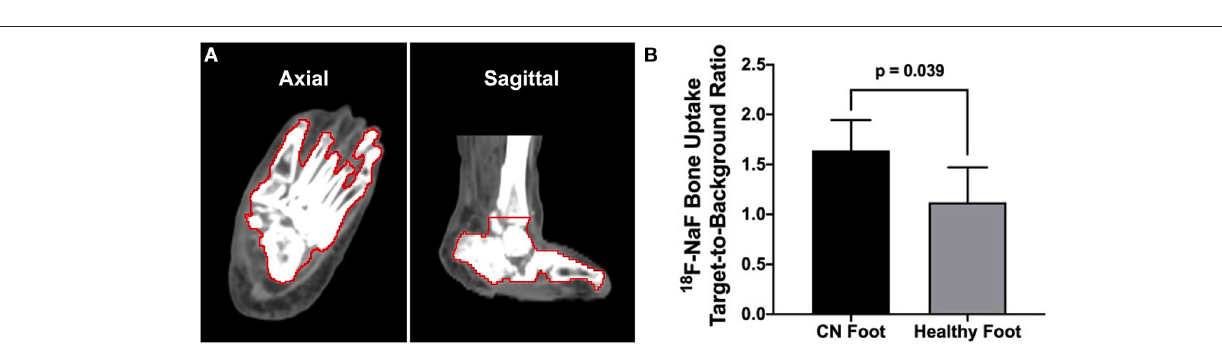
( Figure 4A ). Quantitative PET/CT image analysis demonstrated significantly higher 18 F-NaF uptake (i.e., TBR) in the foot afflicted by CN compared to the healthy foot (CN foot: 1.64 ± 0.30